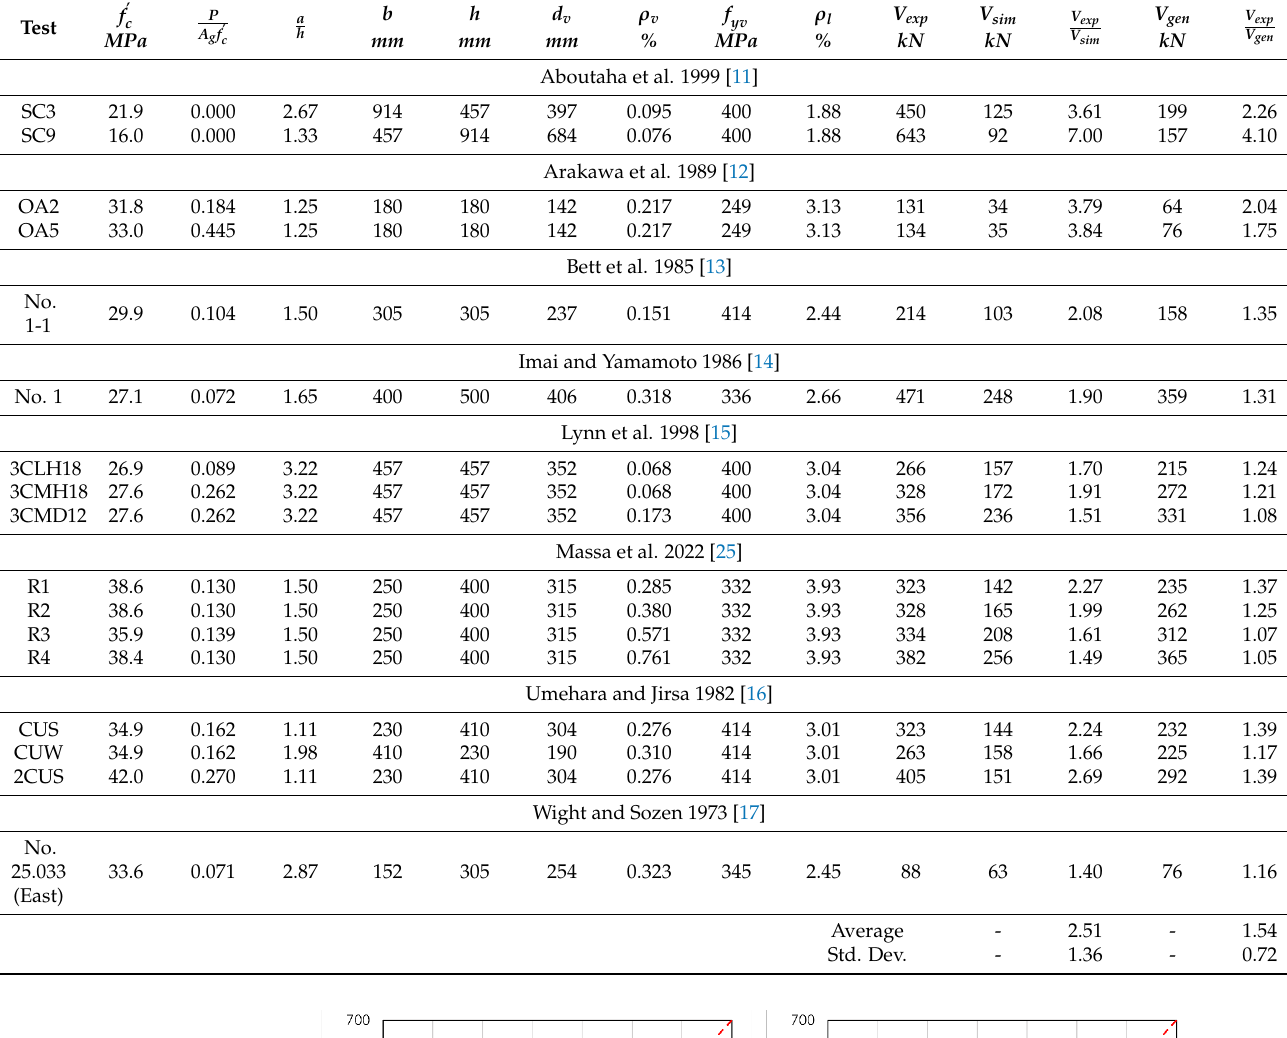
Table 2. Details of rectangular columns and shear strength predictions using the AASHTO Simplified and General Procedures.